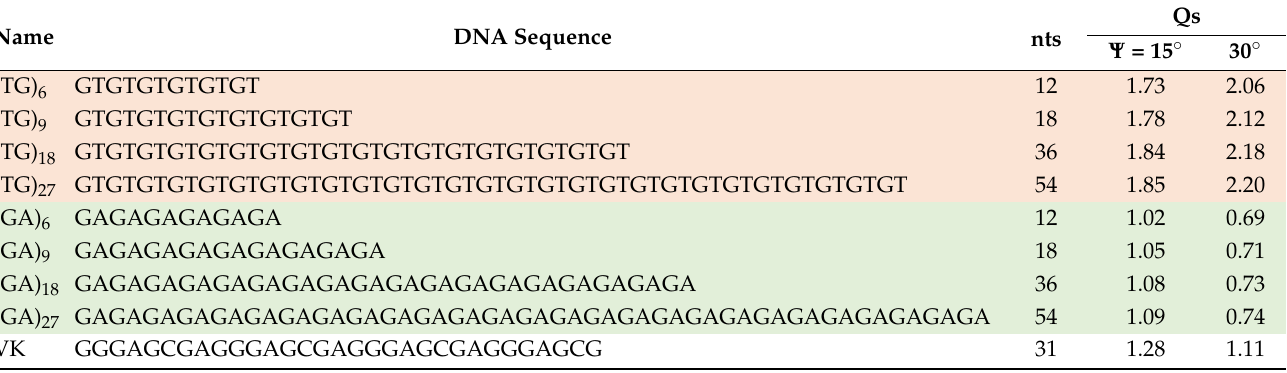
Table 1. DNA sequences analyzed in the study. Sequences highlighted in pale orange and green possess Qs greater than 2 or lie at the interval (0.7–1.1),